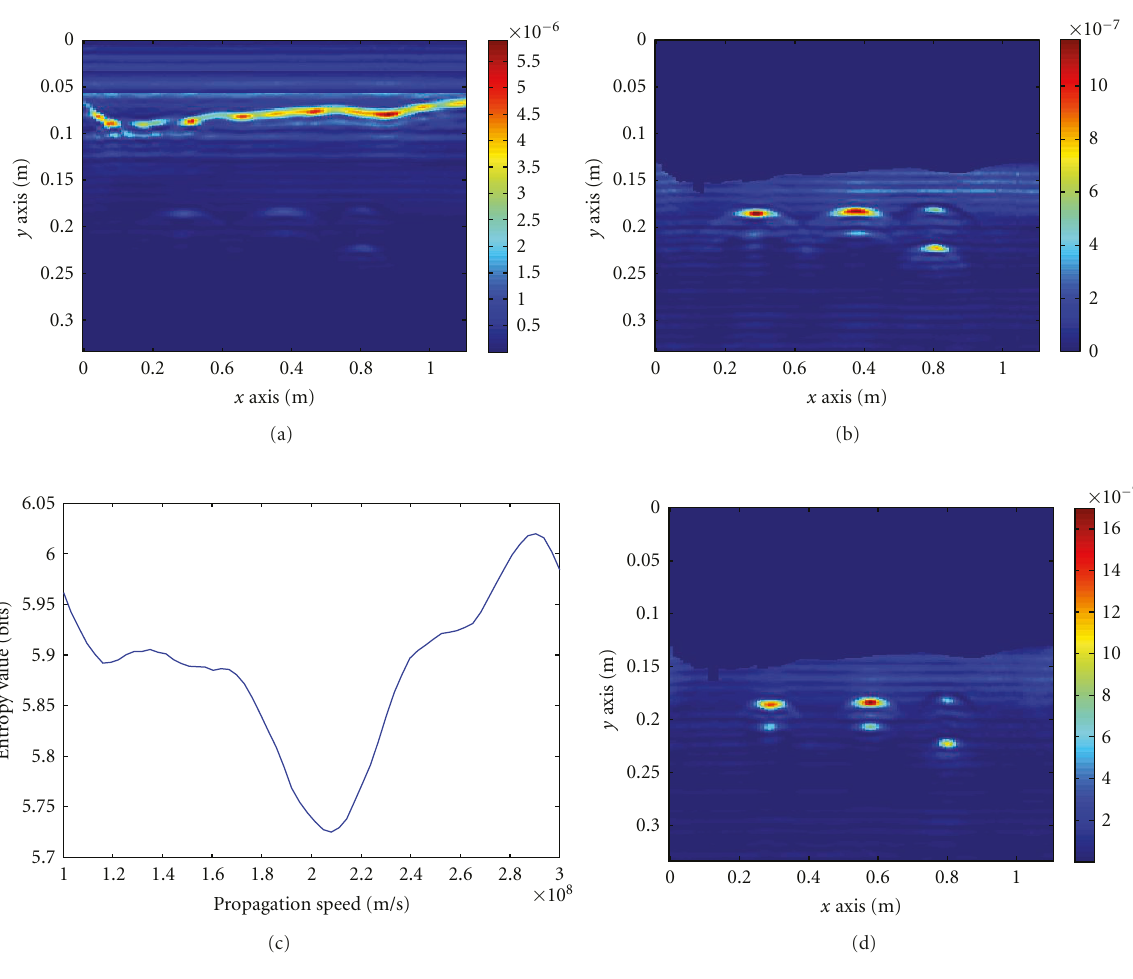
Figure 10: (a) First experimental data set. (b) Denoised data set. (c) Entropy values for the interval [1 × 10 8 m/s, 3 × 10 8 m/s]. (d) Dataset reconstructed using v ∗